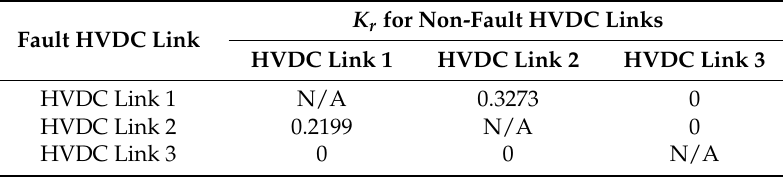
Table A1. K r for rectifier stations of non-fault HVDC links in sending-end systems.